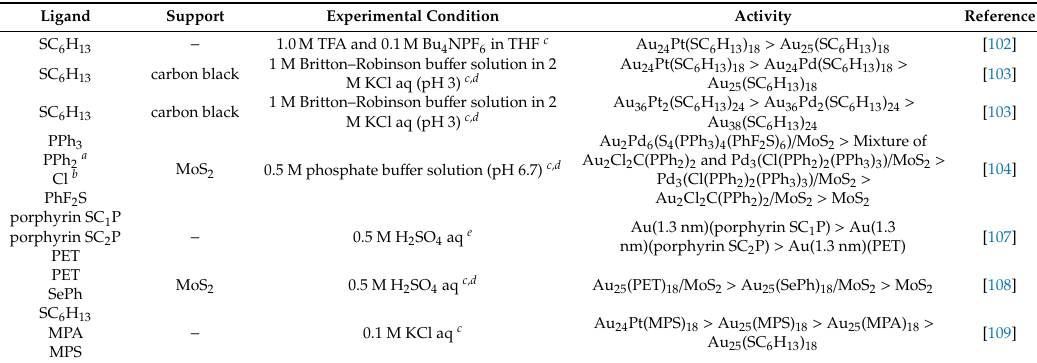
Table 1. Representative references on HER activity of Au n NCs and related alloy